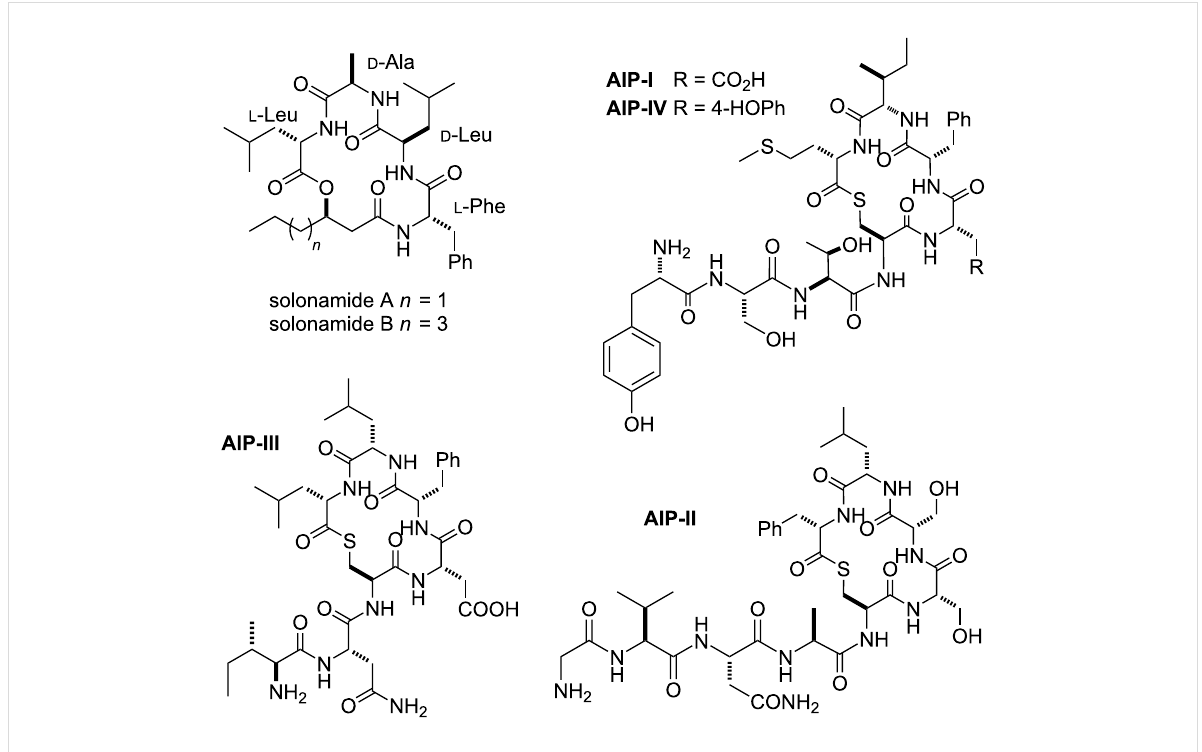
Figure 1: Chemical structure of solonamides and autoinducing peptides (AIP).